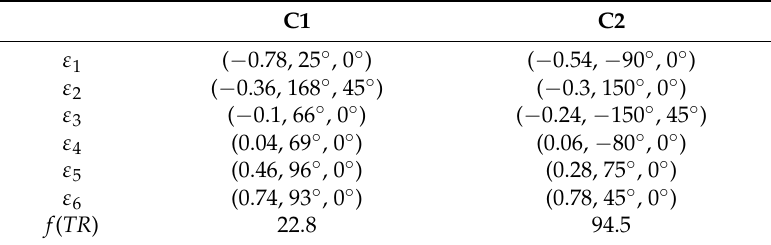
Table 2. Optimized schemes of sensor